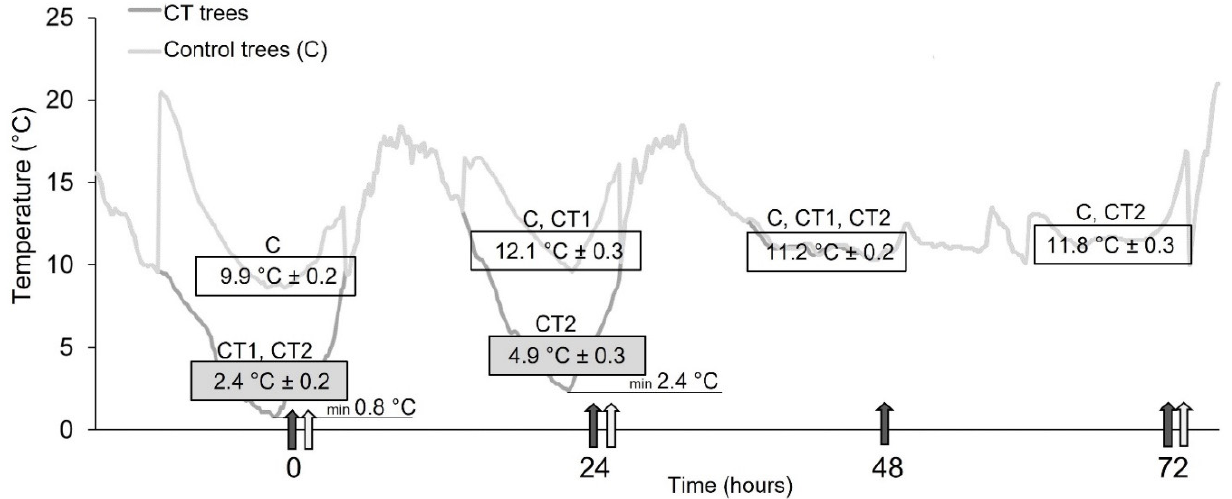
Figure 4. Air temperature ( ◦ C) to which trees were exposed on cold nights under natural conditions and in the greenhouse (CT, cold treatment trees; C, control trees), with the time frame (hours after first exposure) of measurements and sampling. The rectangles show the average (±standard error) 8-h temperature (22:00 to 6:00) under natural cold conditions (filled rectangle) and in the greenhouse (empty rectangle). The black arrows indicate measurements of chlorophyll fluorescence parameters and leaf sampling, while the white arrows indicate measurements of gas exchange parameters.